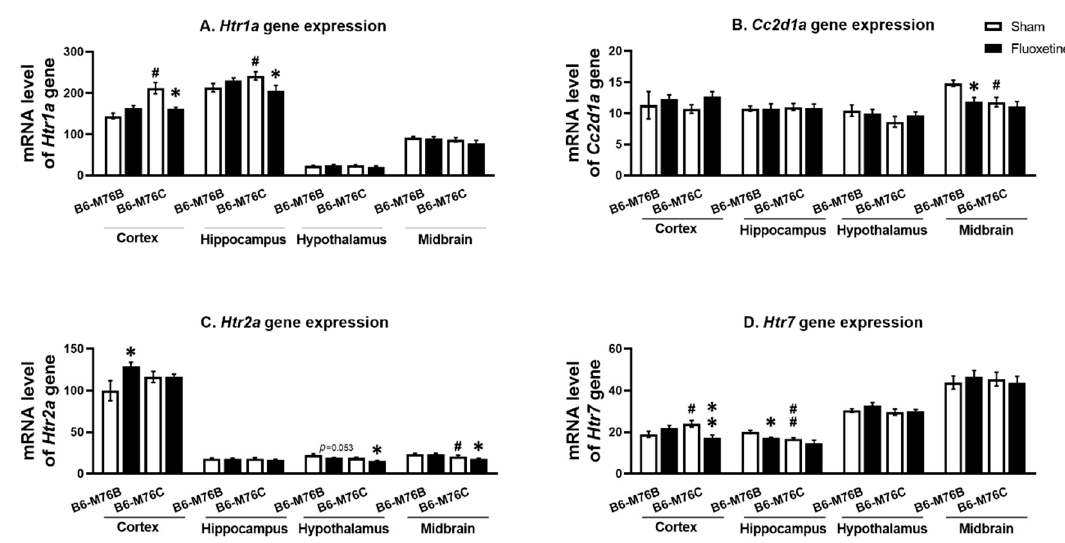
Figure 3. Htr1a ( A ), Htr2a ( C ) and Htr7 ( D ) receptor and Cc2d1a ( B ) genes expression in the brain structures of control and chronically-treated-with-fluoxetine B6-M76C and B6-M76B mice. Gene expression is presented as the number of complementary DNA (cDNA) copies with respect to 100 cDNA copies of rPol2a , n ≥ 8 for each group. All values are presented as mean ± SEM. * p < 0.05, ** p < 0.01 compared to control mice of the same line, # p < 0.05, ## p < 0.01 compared to control B6-M76B mice.